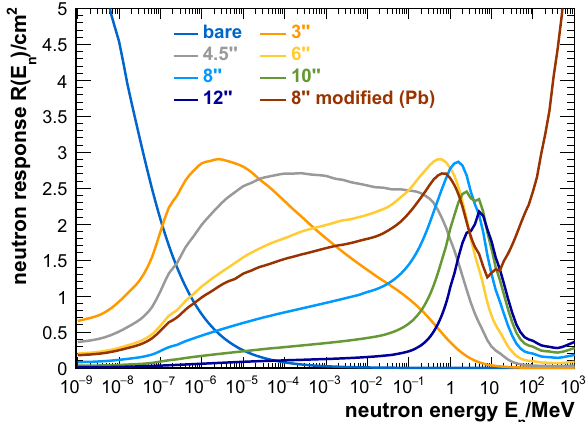
Fig. 1 Neutron response functions of the Bonner spheres used for the measurement. At thermal neutron energies E n ∼ 10 − 9 MeV the response of the bare detector rises to R th = 6 . 2cm